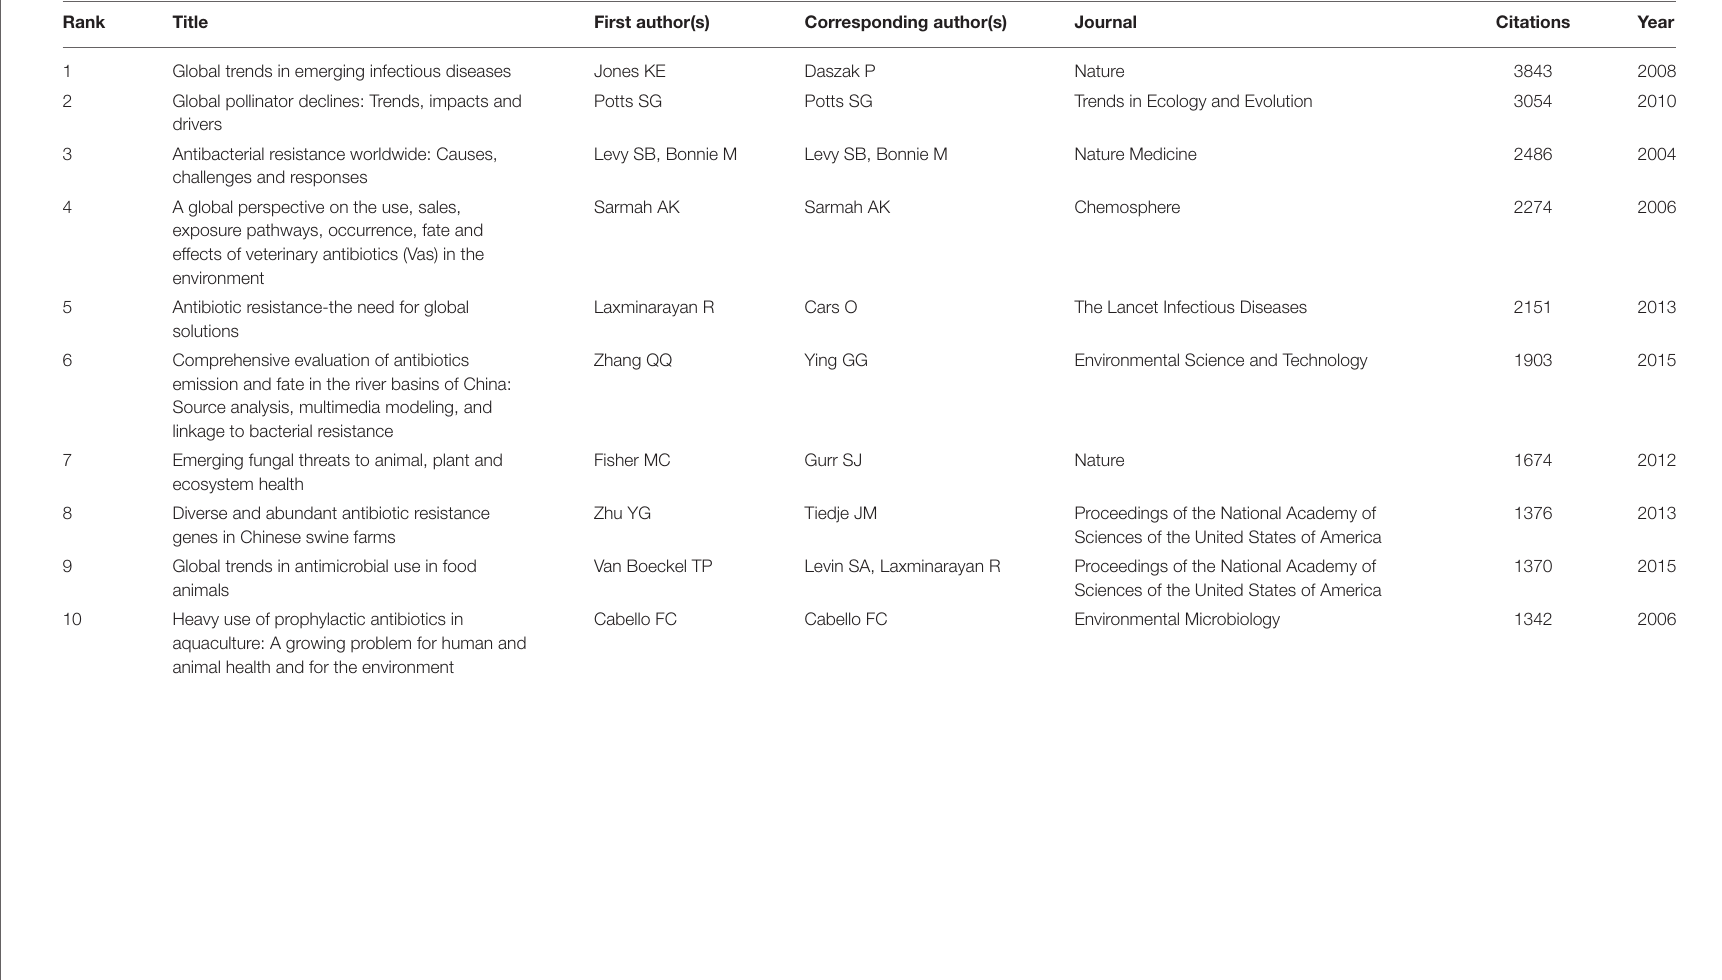
TABLE 3 | Top 10 cited One Health publications in the Scopus database,